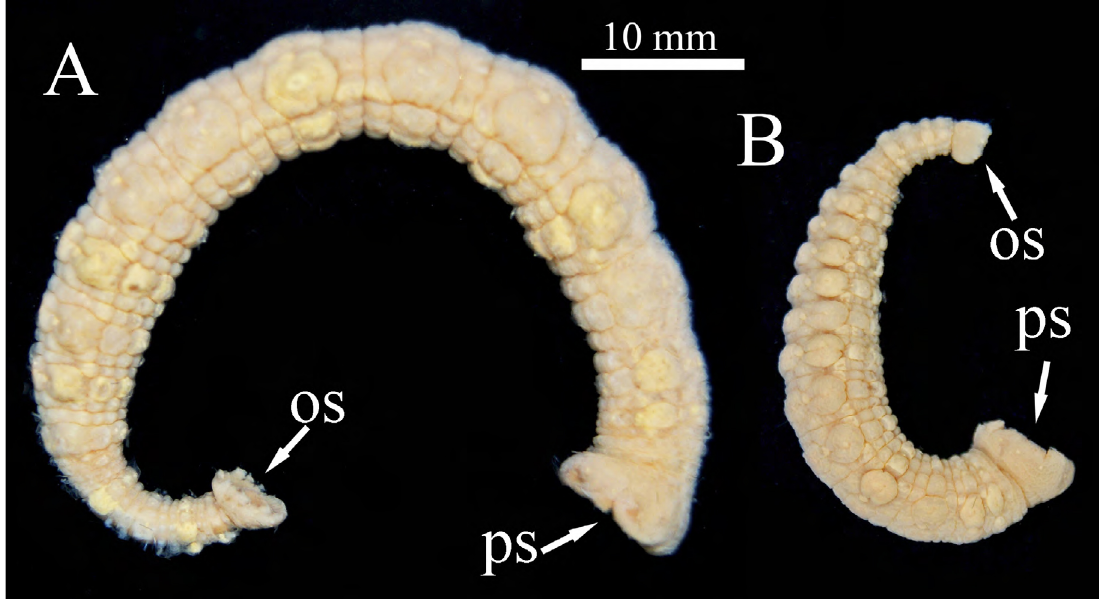
F igure 1. Specimens of Stibarobdella macrothela (LIMCE-0001-AN-H) from Paracuru, Ceará, Brazil (3°25′31″ S, 39°1′29″ W). Abbreviations: os – oral sucker and ps – posterior sucker. A – Measurements: 75.0 mm of total body length, 8.0 mm of posterior sucker diameter and 3.5 mm of anterior sucker diameter. B – Respective measurements: 30.0 mm, 4.5 mm and 2.0